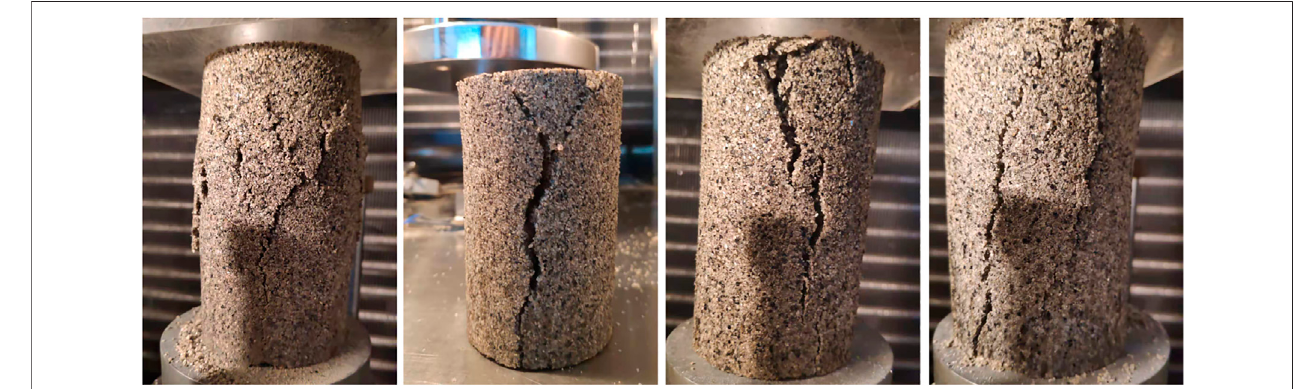
FIGURE 5 | Typical photos of damaged samples.